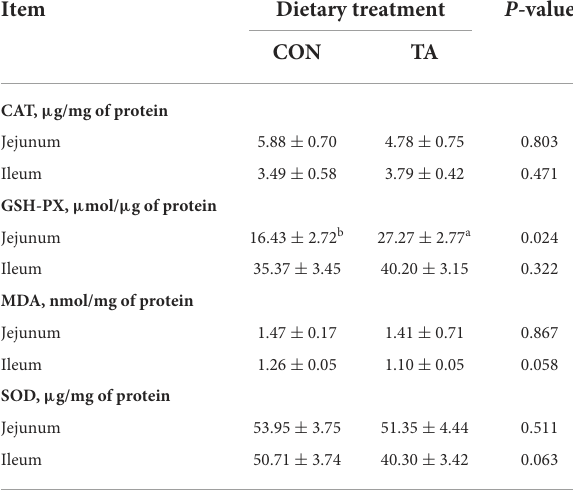
TABLE 1 The jejunal and ileal antioxidant capacity of weaning piglets 1 .